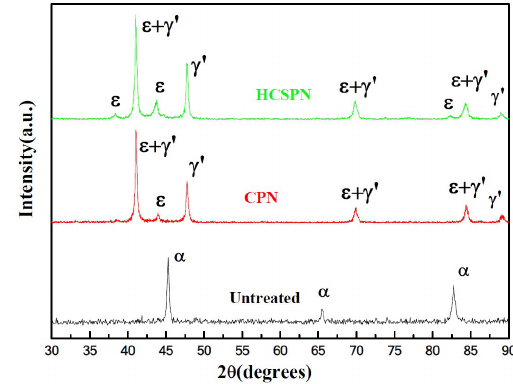
Figure 2. X-ray diffraction patterns of the different